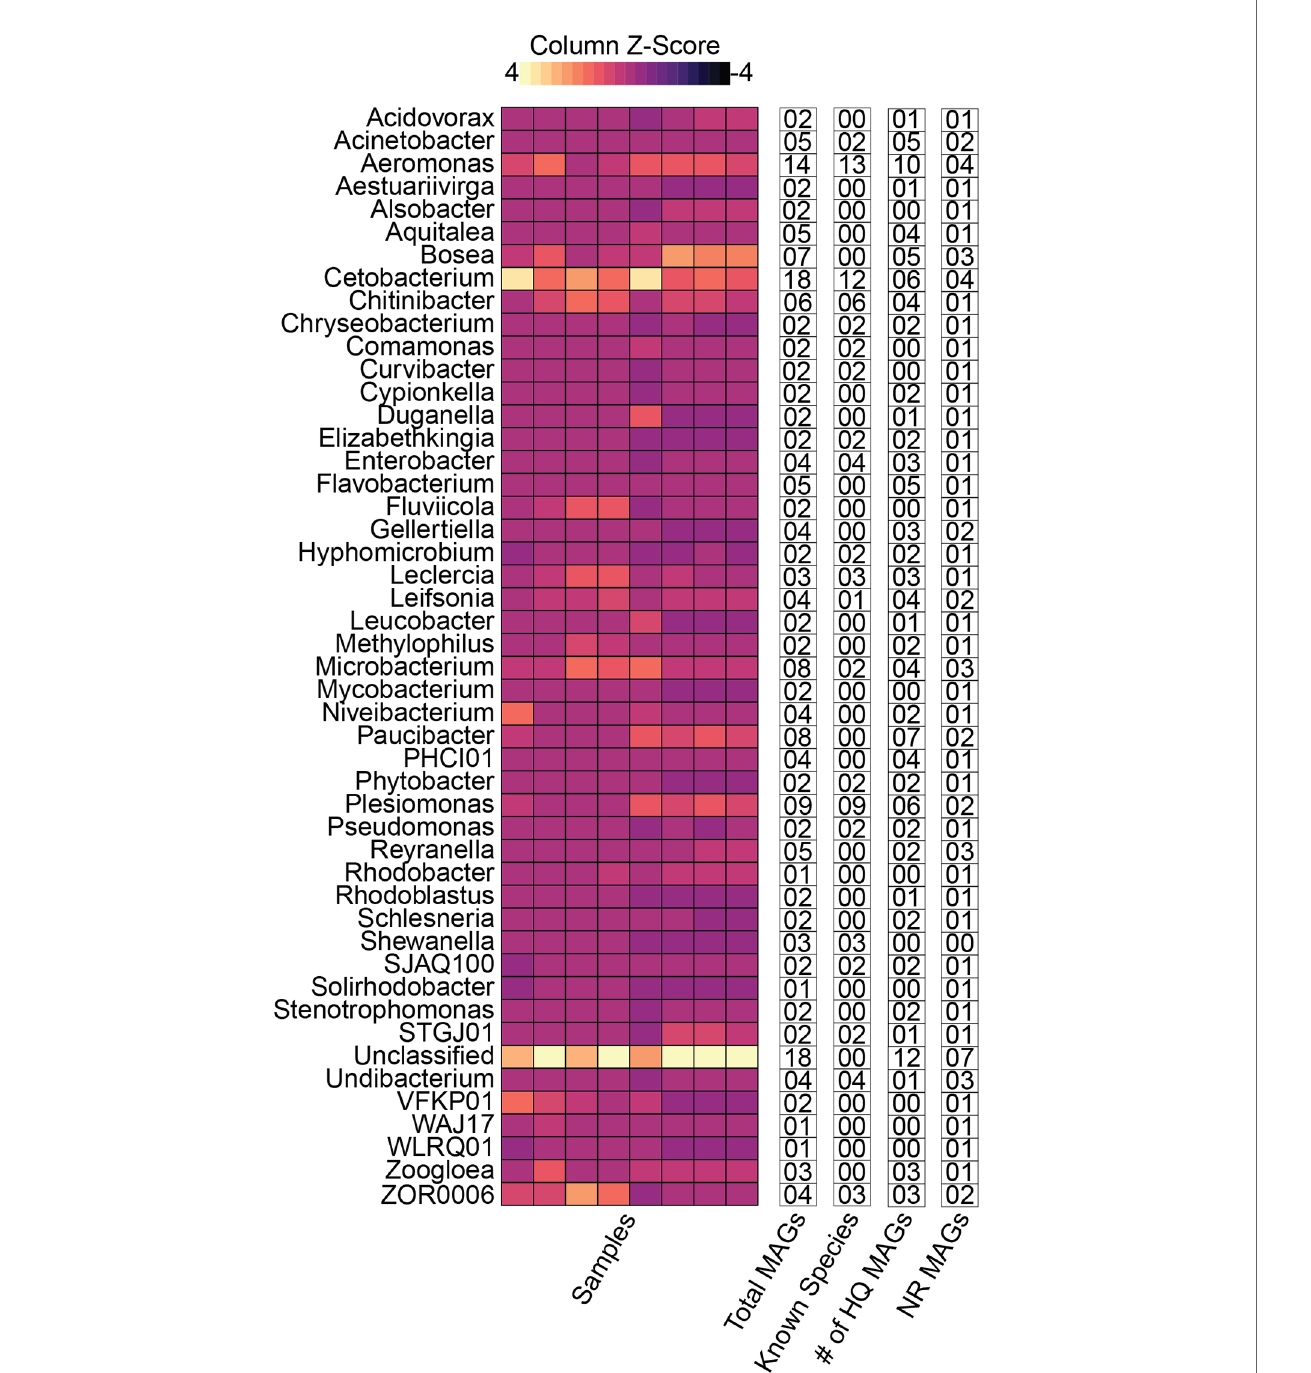
FIGURE 3 | Distribution of the zebra fi sh MAGs at genus level and other categories. The relative abundance at the genus level is shown using the heatmap. The text columns highlight the following: (1) the total number of MAGs in a given genus, (2) the number of MAGs which could be successfully classi fi ed to species-level (3) the number of high-quality MAGs, and (4) the number of non-redundant (NR) MAGs in respective genera. These results indicate that majority of the MAGs were classi fi ed as members of Cetobacterium or an unclassi fi ed genus. In contrast, the highest number of MAGs (12) were successfully classi fi ed to species level from the genus Aeromonas . Additionally, the genus Paucibacter contained the highest number of unknown species relative to the total number of MAGs in the genus. In contrast, the Unclassi fi ed MAGs had the maximum number of NR MAGs.